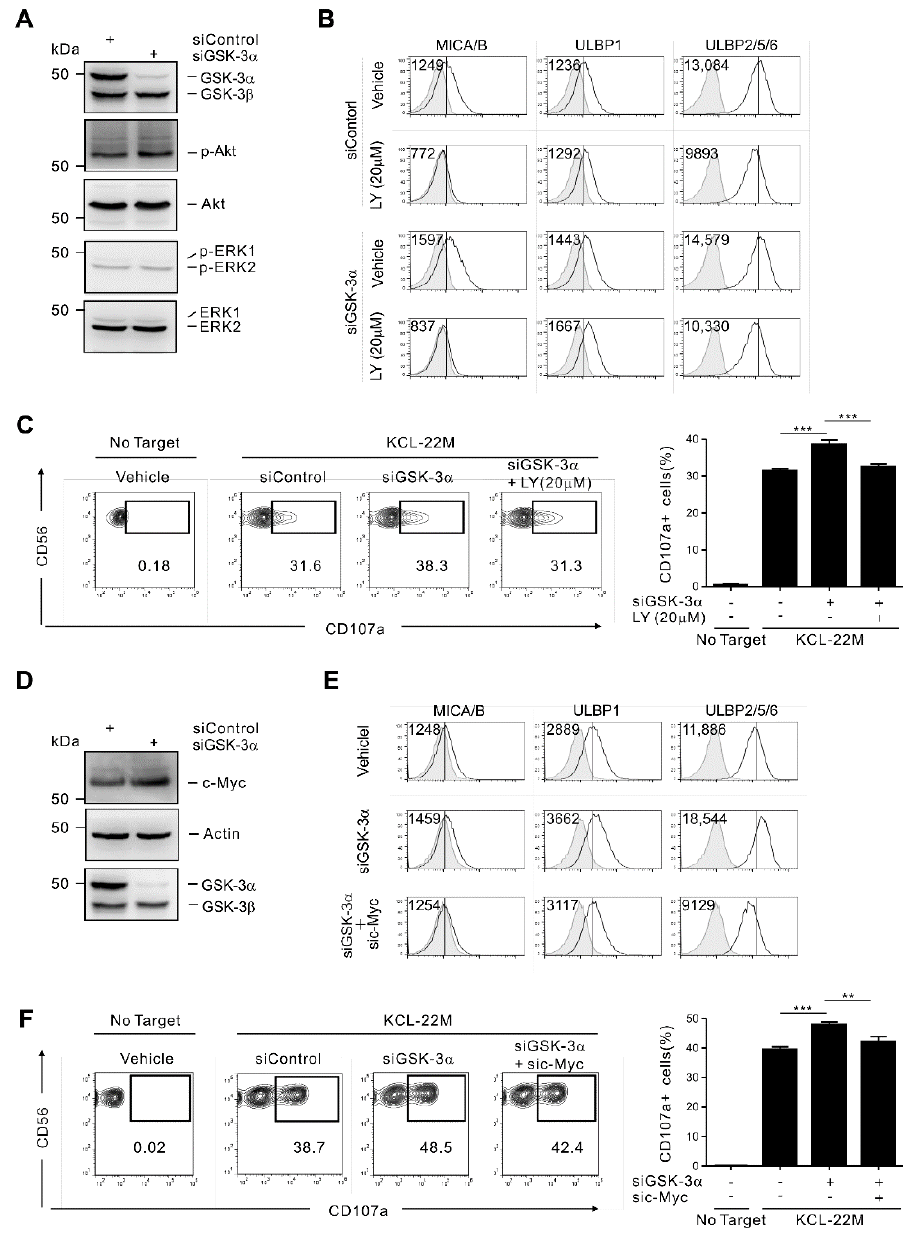
Figure 3. GSK-3 α knockdown enhances NKG2DL expression via Akt signaling and c-Myc activity. ( A ) Total cell lysates from KCL-22M cells transfected with control siRNA or GSK-3 α -specific siRNAs for 48 h were immunoblotted for GSK-3 α / β , p-Akt, Akt, p-ERK1/2, and ERK1/2. ( B ) Analysis of NKG2DL surface expression on KCL-22M cells after siRNA-mediated knockdown of GSK-3 α in the absence or presence of the PI3K inhibitor LY (20 µ M) for 48 h. ( C ) Degranulation of NK cells in PBMCs against KCL-22M cells after siRNA-mediated knockdown of GSK-3 α in the absence or presence of the PI3K inhibitor LY (20 µ M) for 48 h. Representative flow cytometry profile (left) and summary graph (right) demonstrating the percentage of CD107a + on CD3 − CD56 + NK cells. ( D ) Total lysates of KCL-22M cells transfected with control siRNA or a GSK-3 α -specific siRNA for 48 h were immunoblotted for c-Myc, β -actin, and GSK-3 α / β . ( E ) Analysis of NKG2DL surface expression on KCL-22M cells after siRNA-mediated knockdown of GSK-3 α or GSK-3 α and c-Myc. ( F ) Degranulation of NK cells in PBMCs against KCL-22M cells depleted of GSK-3 α or GSK-3 α and c-Myc. Representative flow cytometry profile (left) and summary graph (right) demonstrating the percentage of CD107a + on CD3 − CD56 + NK cells. Values represent the means ± s.d. Data are representative of at least three independent experiments. ** p < 0.01; *** p <